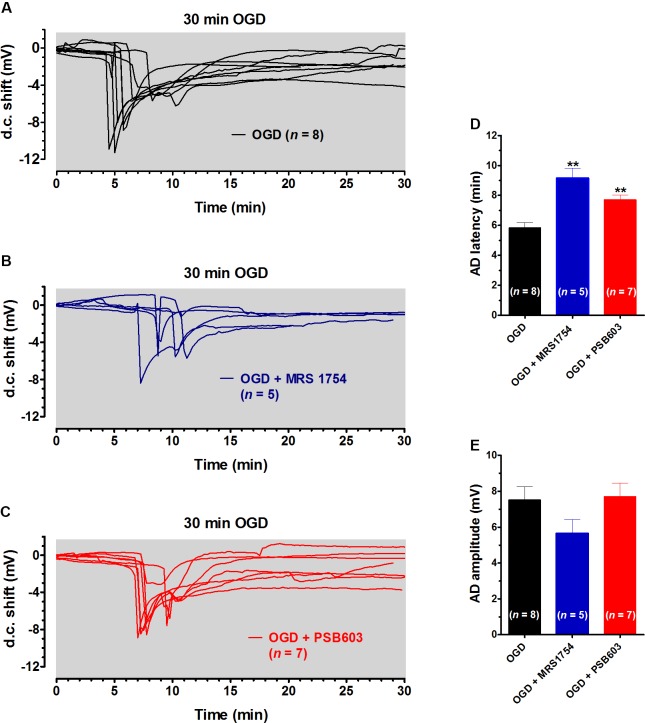
MRS1754 and PSB603 delayed the appearance of AD induced by 30 min OGD in rat hippocampal slices. (A–C) The graphs show the d.c. shift traces during 30 min OGD in untreated OGD slices (A, n = 8), in the presence of 500 nM MRS1754 (B, n = 5), or 50 nM PSB603 (C, n = 7). (D) Each column represents the mean ± SEM of AD latency recorded in hippocampal slices during 30 min OGD in different experimental groups. AD was measured from the beginning of OGD insult. Note that both adenosine A2B receptor antagonists significantly delayed AD development. ∗∗P < 0.01 vs. OGD, One-way ANOVA followed by Newman–Keuls Multiple comparison test. (E) Each column represents the mean ± SEM of AD amplitude recorded in the CA1 during 30 min OGD. The number of slices is reported in the columns.